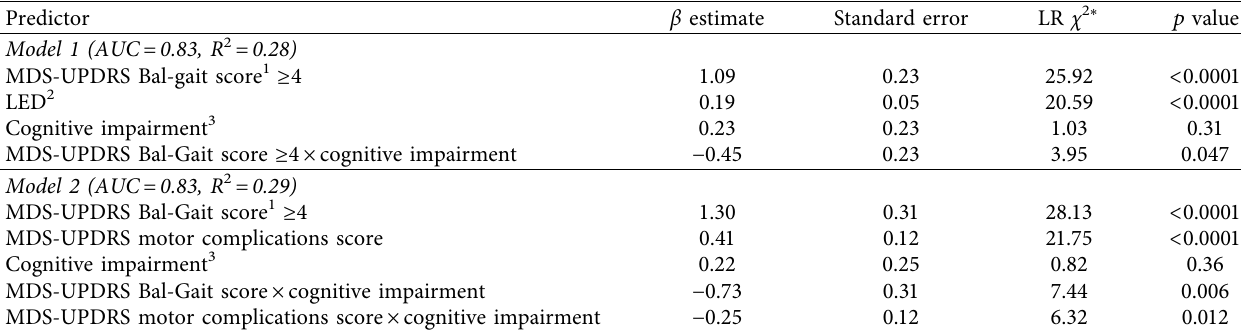
Table 4: Results of multivariate nominal logistic regression on freezing of gait grouping.